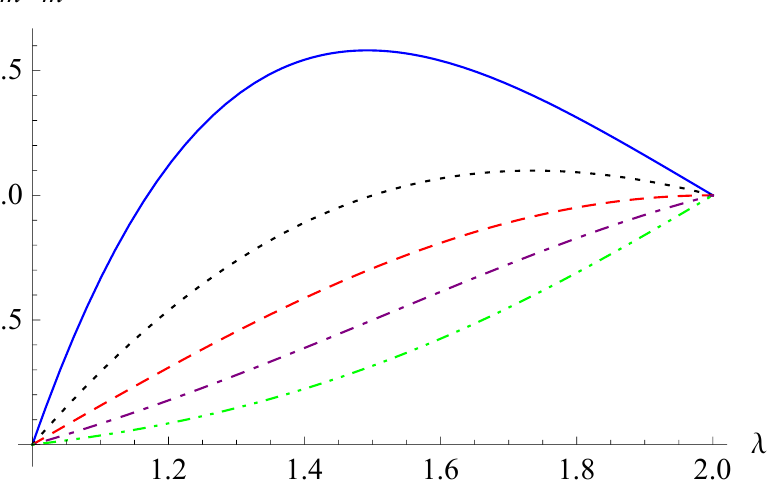
Figure 2. The curves of ˜ m − m versus λ for η = 1 and for ω = 0.2 (solid line), 0.5 (dotted line), 1 (dashed line), 2 (dot-dashed line), 5 (dot-dot-dashed